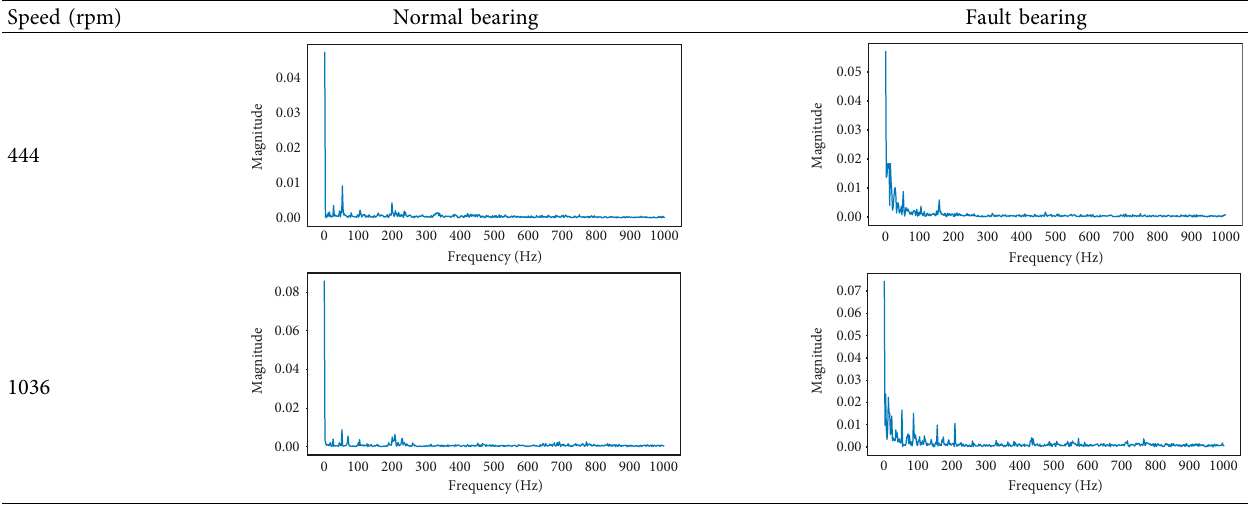
Table 8: Frequency domain diagram of acoustic